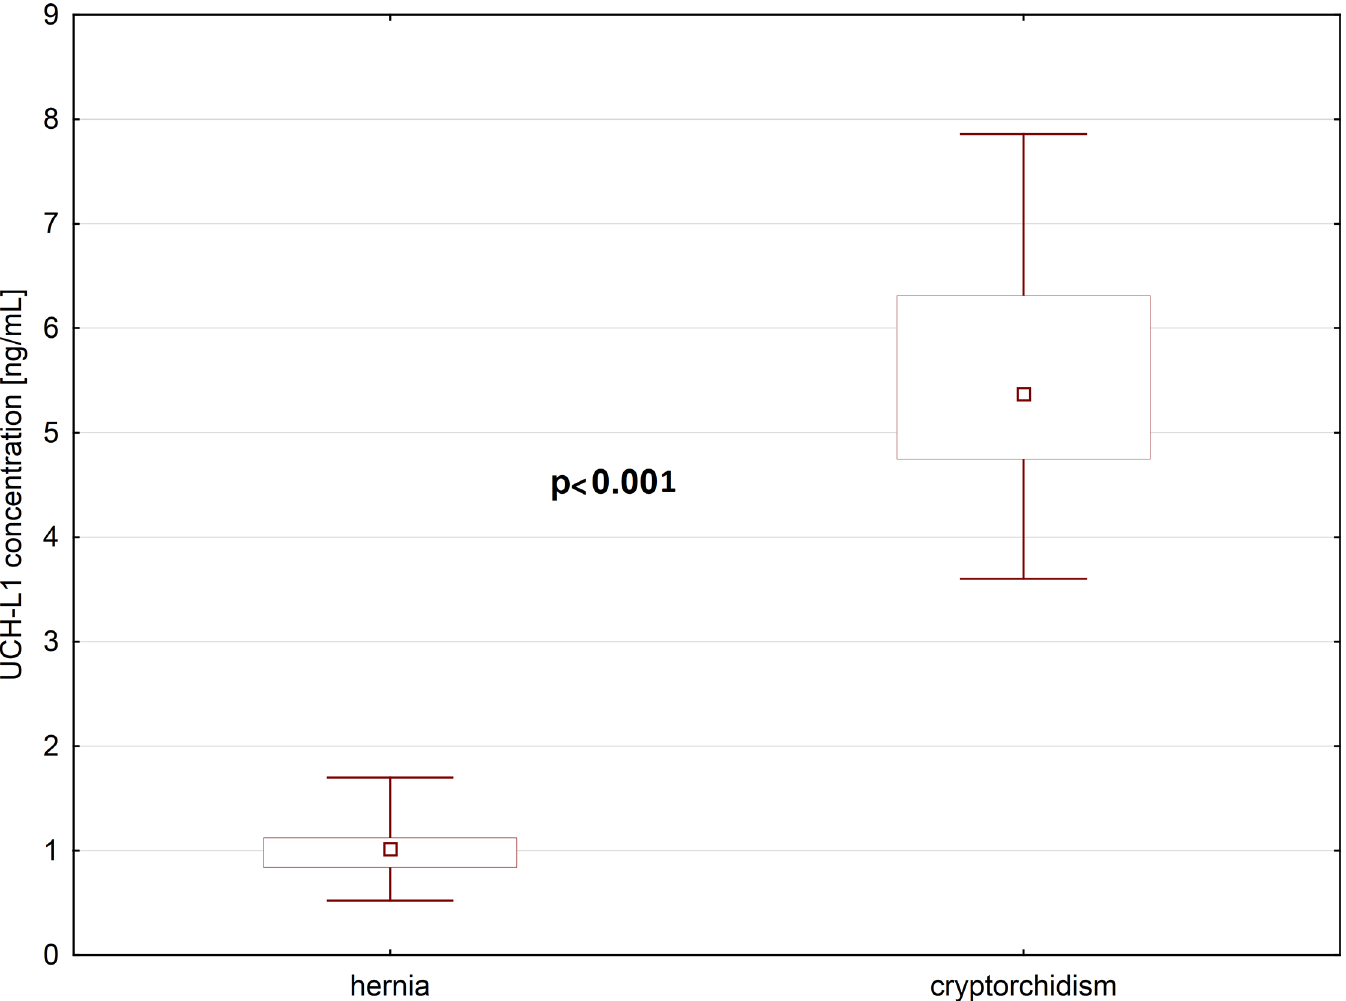
Fig 1. Plasma UCHL-1 concentration in children with hernia and cryptorchidism (N = 50).